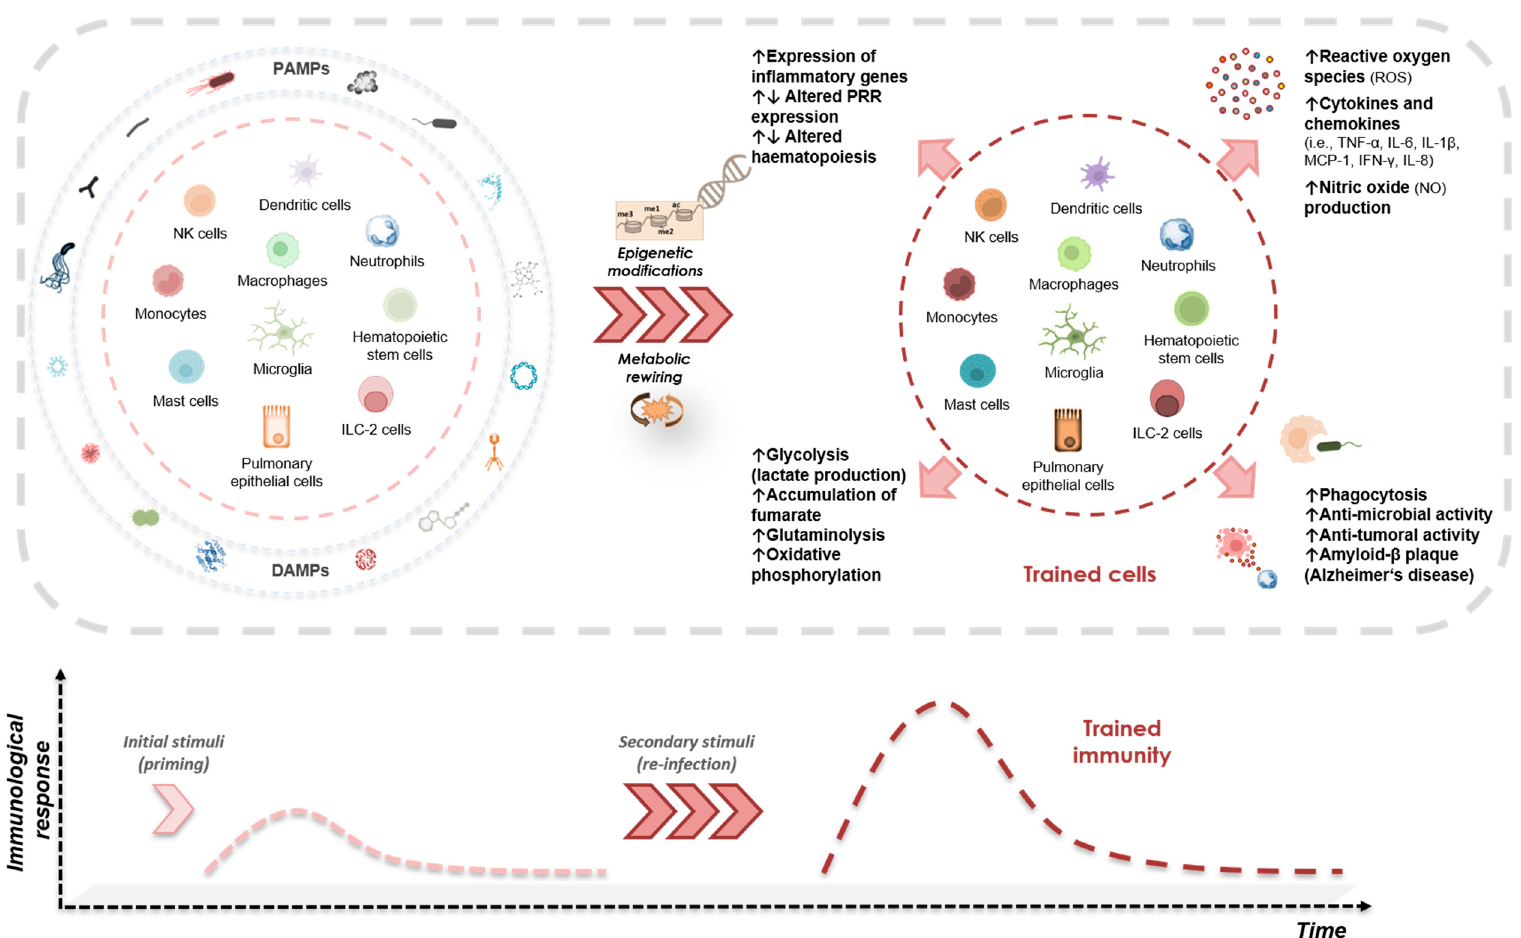
Figure 2. Stressor-dependent induction of trained immunity. Innate immune cells as well as non-immune cells primed by specific exogenous (i.e., PAMPs) and endogenous (i.e., DAMPs) signals evoke long-term non-specific functional modifications mediated by epigenetic and metabolic rewiring toward a secondary insult. Trained cells express a multi-level entity of features characterized by the increased production of inflammatory mediators and altered epigenetic and metabolic marks, and reflected functionally by changes occurring in several cellular activities.